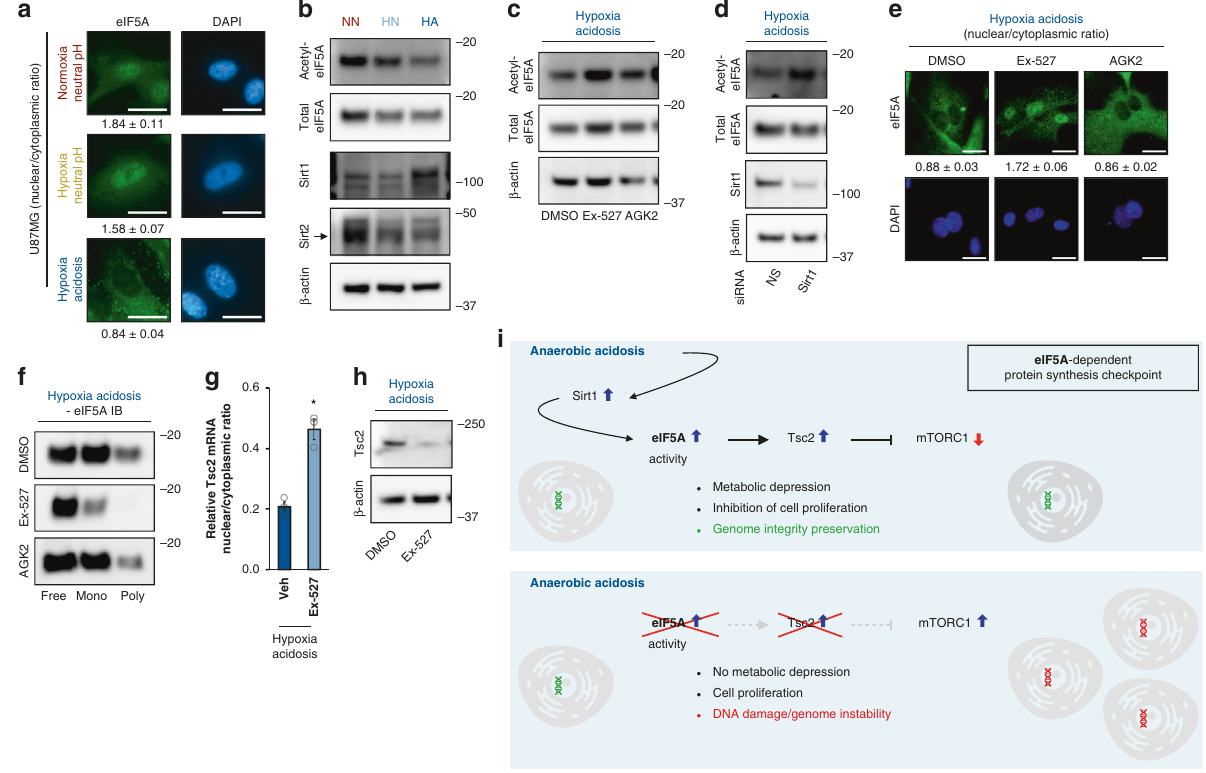
Fig. 7 pH-sensing Sirt1 modulates eIF5A through deacetylation. a Representative images of eIF5A immunocytochemistry showing eIF5A subcellular localization in U87MG subjected to indicated conditions. Data represent mean ± SEM ( n = 5). Scale bars: 20 μ m. b Representative immunoblots of U87MG subjected to indicated conditions. NN normoxia-neutral pH, HN hypoxia neutral, HA hypoxia acidosis ( n = 3). Representative c immunoblots ( n = 3) and e immunocytochemistry images ( n = 5) of U87MG were treated with the indicated compounds under the indicated conditions. Scale bars: 20 μ m. Ex-527: Sirt1 inhibitor; AGK2: Sirt2 inhibitor; DMSO: vehicle. d Representative immunoblots of U87MG depleted of Sirt1 ( n = 3). f Representative immunoblots of U87MG ribosome-density fractions treated with the indicated compounds. Mono: light monosome fraction. Poly: heavy-polysome fractions ( n = 3). g Effect of Sirt1 inhibition (using ex-527) on Tsc2 mRNA subcellular localization under hypoxia-acidosis conditions. NS nonsilencing. Data represent mean ± SEM ( n = 3). An asterisk indicates p < 0.05 compared with DMSO vehicle, two-sided student ’ s t test. h Representative immunoblots of U87MG treated with the Sirt1 inhibitor ex-527 ( n = 3). i Summary model of the Sirt1/eIF5A/Tsc2/mTORC1 pathway that enables metabolic depression and proliferative inhibition during anaerobic acidosis to prevent DNA